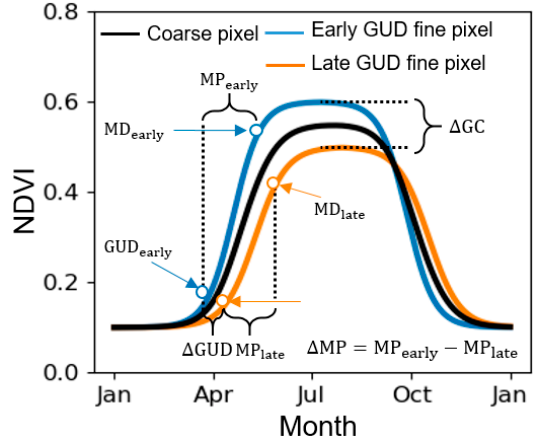
Figure 1. Illustration of three factors ( ∆ GUD fine , ∆ MP fine , ∆ GC fine ) for a composite case in which the coarse pixel contains two fine pixels. Two fine pixels were represented as the double-logistic curves to illustrate the whole vegetation index ( VI ) time-series of vegetation. MD refers to the maturity date.